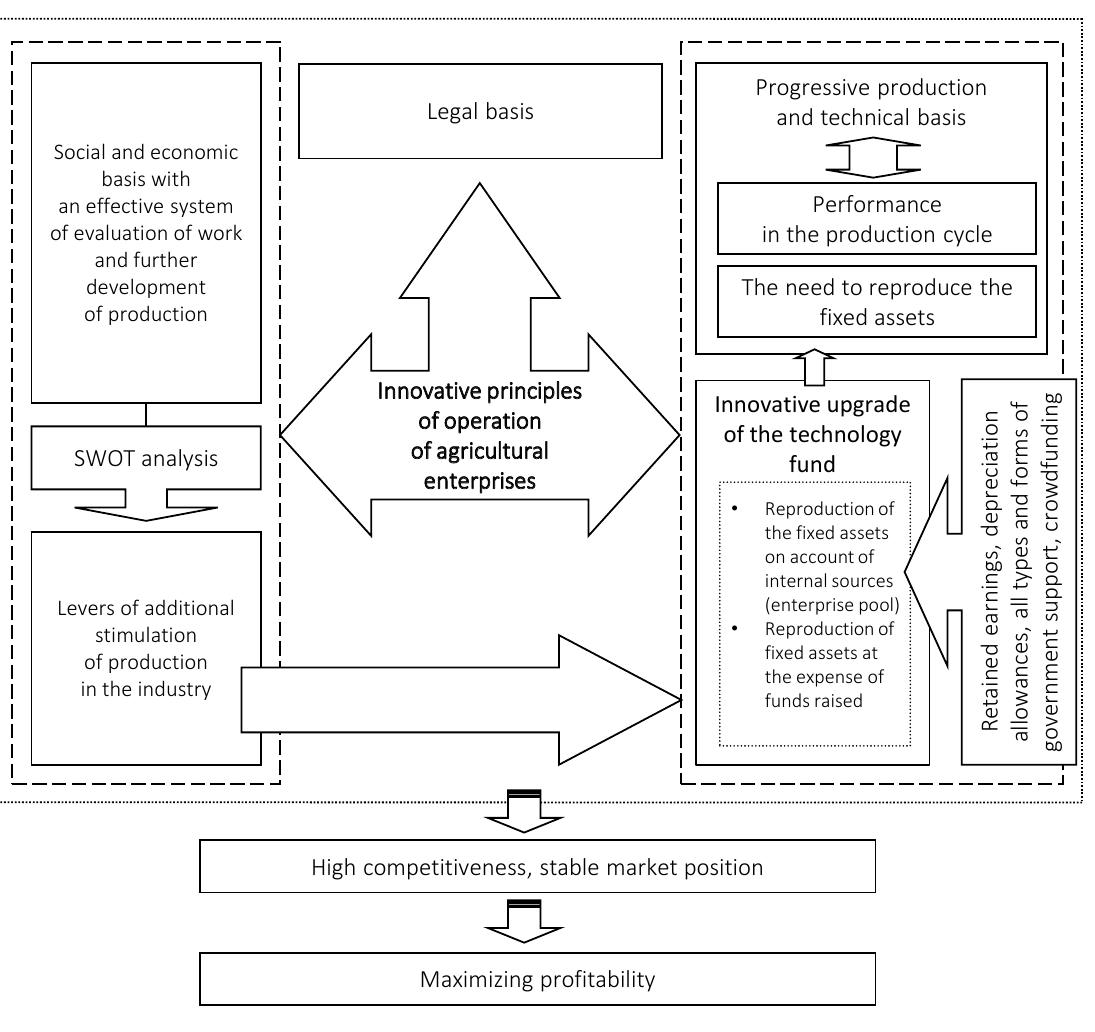
Figure 1. Organizational and methodological principles of the performance of agricultural enterprises on an innovative